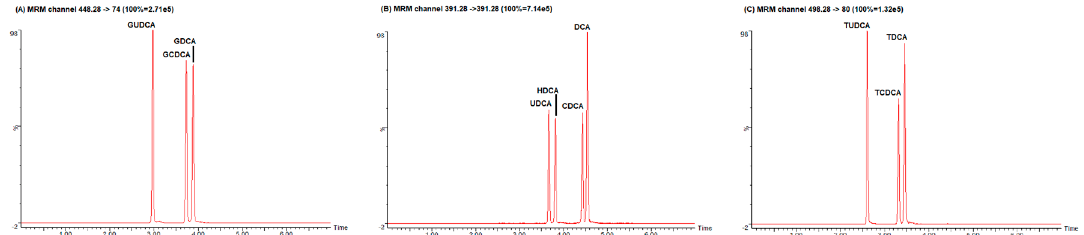
Figure 2. Chromatographic separation of three groups of isobar compounds. ( A ) Isobaric compound: GUDCA, GCDCA, GDCA; ( B ) Isobaric compounds: UDCA, HDCA, CDCA, DCA; ( C ) Isobaric compounds: TUDCA, TCDCA, TDCA. Isobaric compounds (i.e., compounds that share mass but are